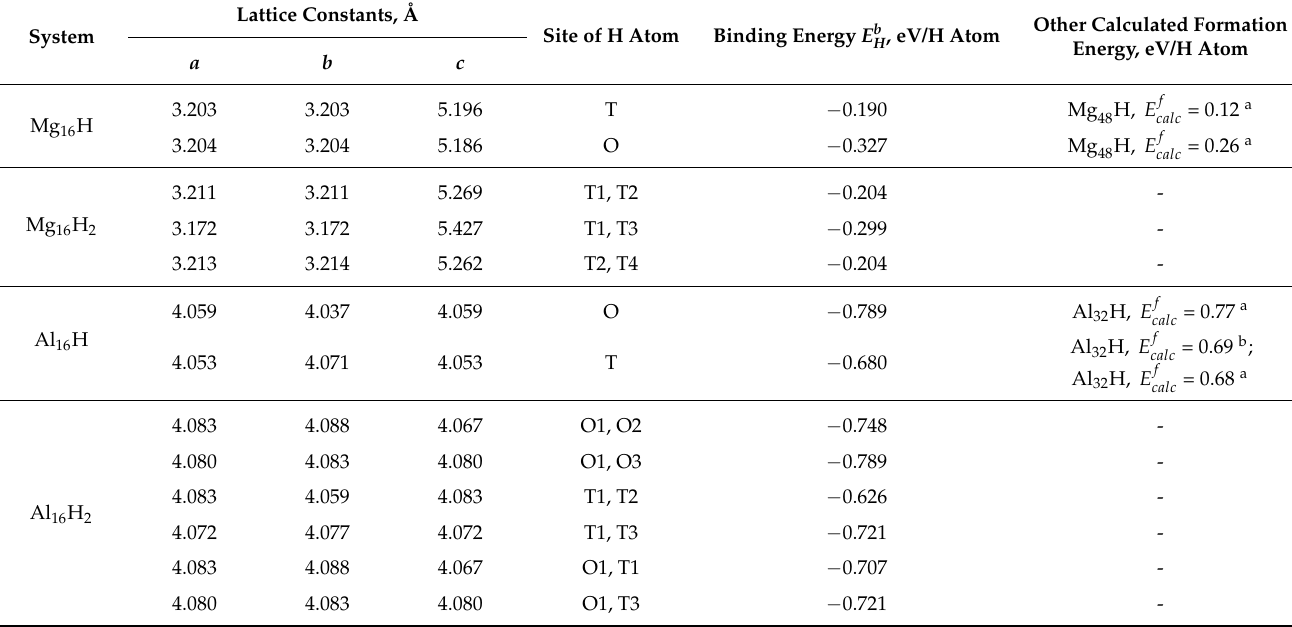
Table 2. The binding energy of Al 16 H y and Mg 16 H y . E f previous theoretical studies for